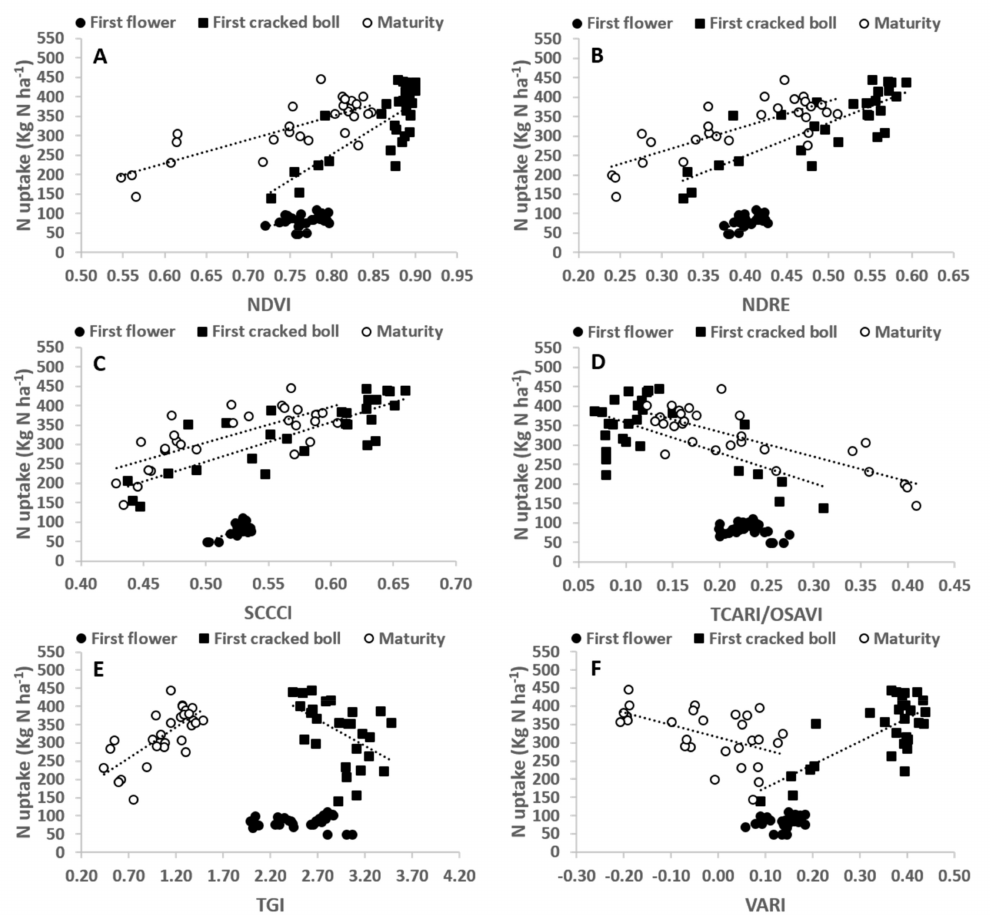
Figure 5. Relationships obtained between nitrogen uptake (N uptake) and the normalized difference vegetation index (NDVI; A ), normalized difference red edge index, NDRE ( B ), simplified canopy chlorophyll content index (SCCCI; C ), transformed chlorophyll absorption reflectance index normalized by the optimized soil adjusted vegetation index (TCARI/OSAVI; D ), triangular greenness index (TGI; E ) and visible atmospherically resistant index (VARI; F ) at first flower, first cracked boll and